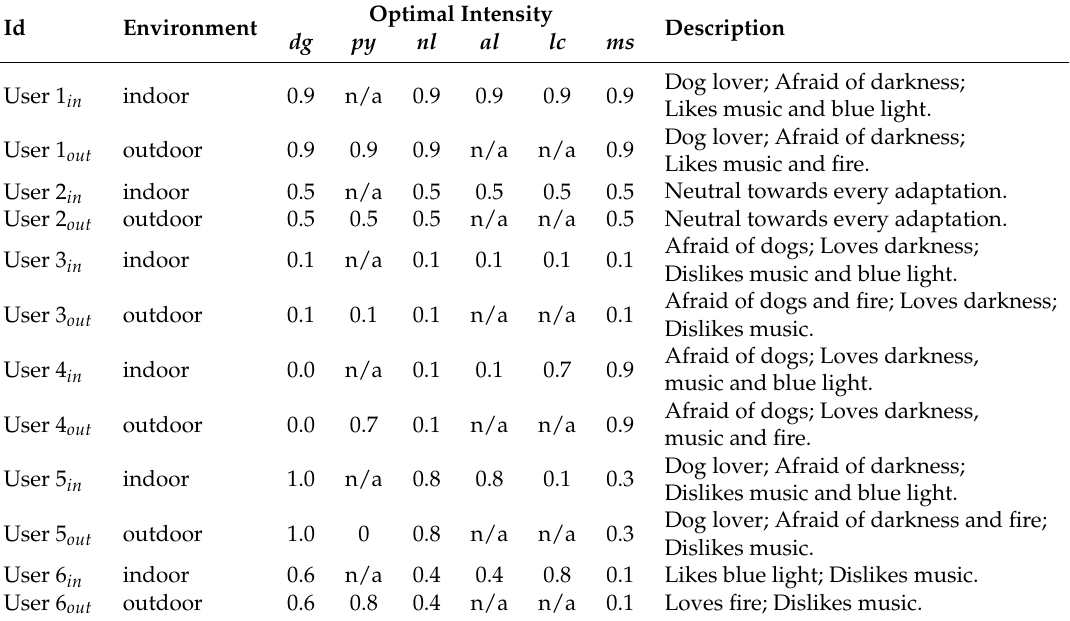
Table 4. User profiles used for